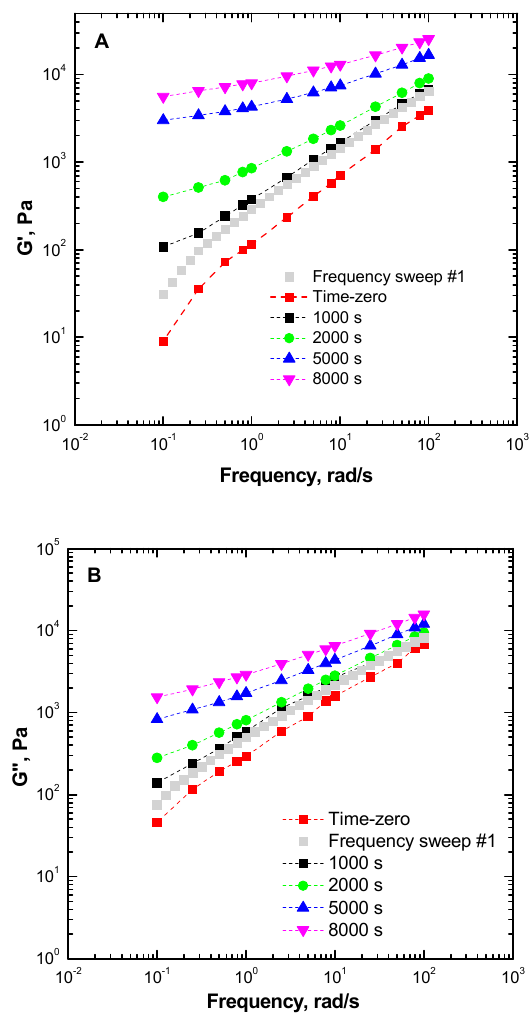
Figure 4. Isochronal storage modulus ( A ) and loss modulus ( B ) of ENR25 at 180 °C, collected at different times during the TRMS tests.